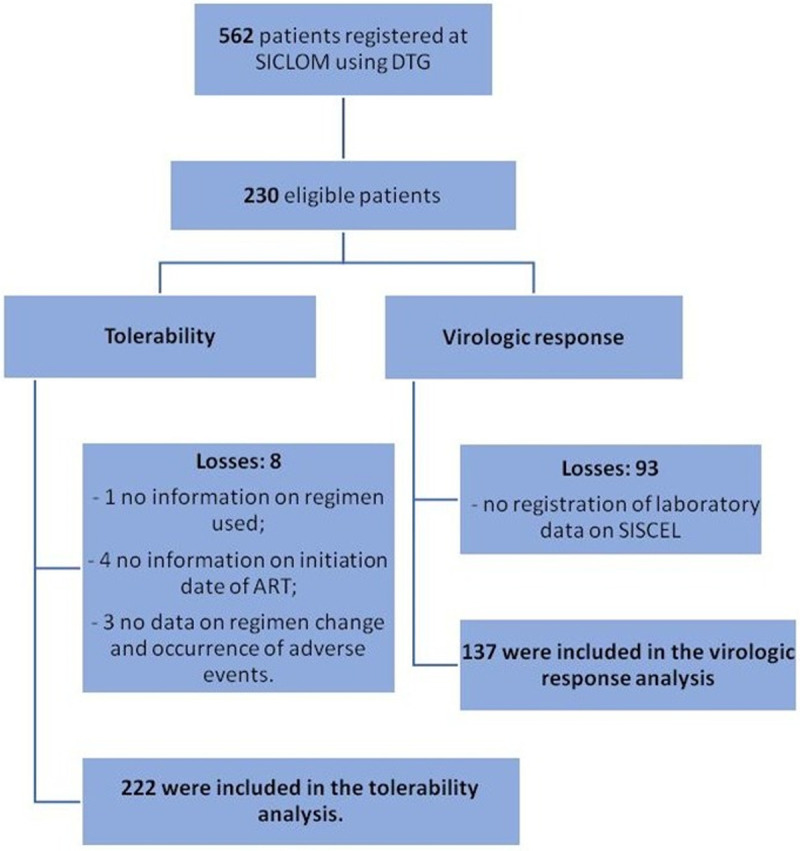
Study flowchart.